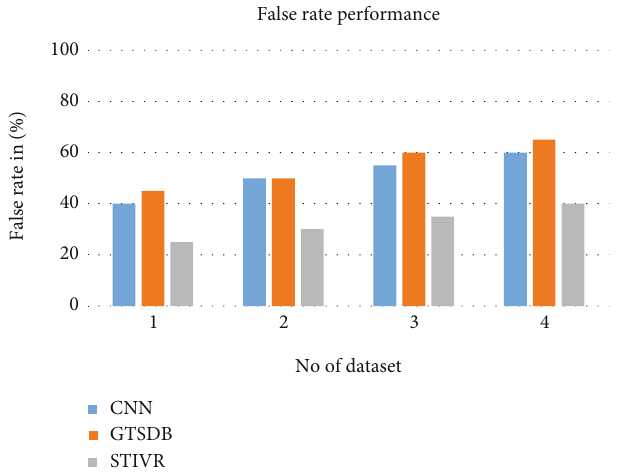
Figure 7: The evolution of the false rate